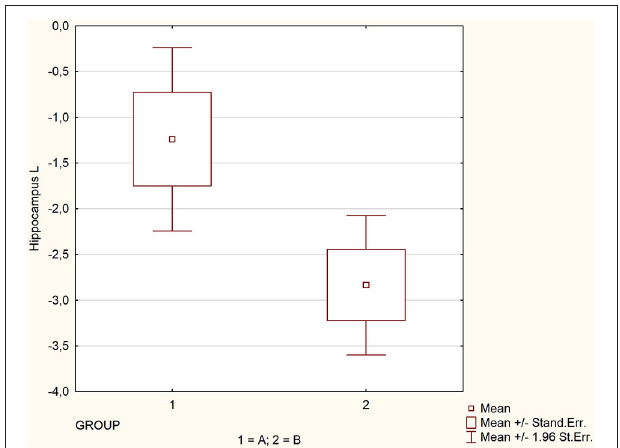
FIGURE 1 | Comparison of perfusion in regions significantly affected by glycemic variability.